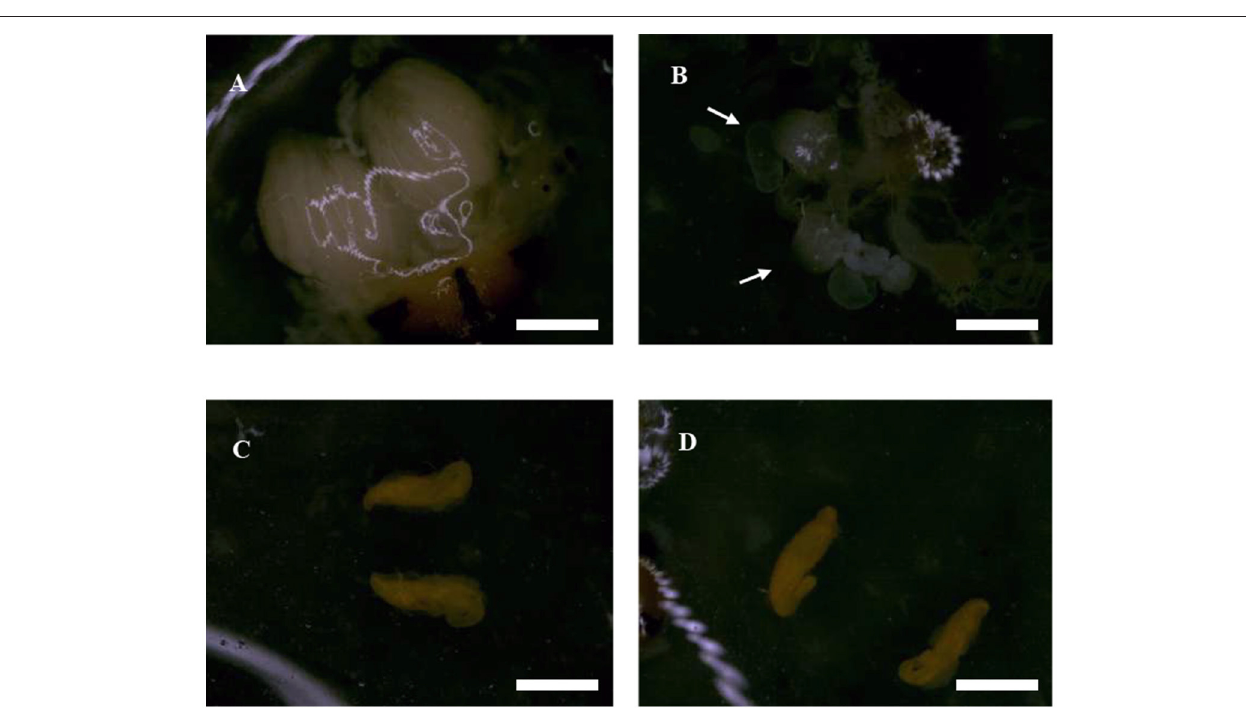
FIGURE 2 | Morphological characteristics of reproductive organs in irradiated and untreated flies observed by optical microscopy. (A) Ovary of an untreated female. (B) Ovary of an irradiated female. The white arrow indicated the location of ovary. (C) Testis of untreated male. (D) Testis of irradiated male. Scale bars = 3cm.